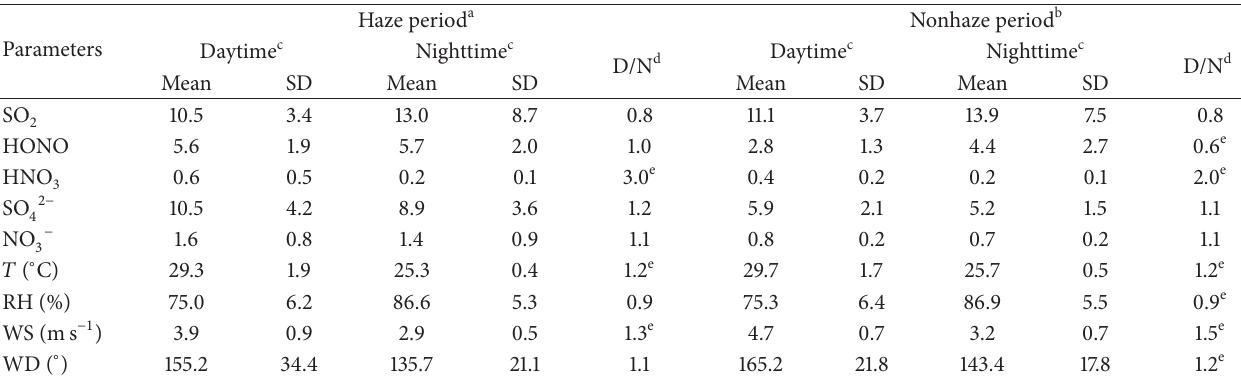
Table 2: Daytime and nighttime levels of air pollutants (unit: 𝜇 gm − 3 ) and meteorological parameters based on 12 hr average. Parameters